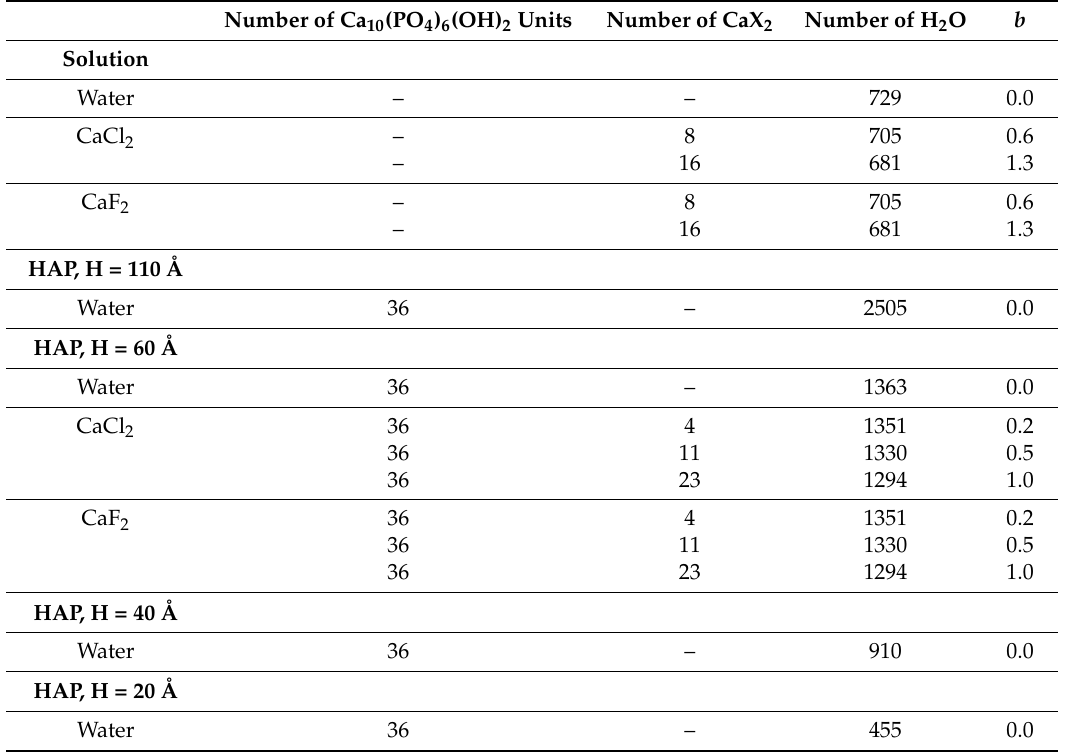
Figure 1. ( a ) HAP-water system (Ca = green, phosphate = pink, O = red, H = white) with a pore size of 110 Å. ( b ) Parallel view of the HAP–water interface. ( c ) Detailed view of the surface local environment. Table 1. Bulk solutions and hydroxyapatatite nanopores considered in this study. Concentration of calcium chloride and calcium fluoride in mol·kg − 1 ( b ) .